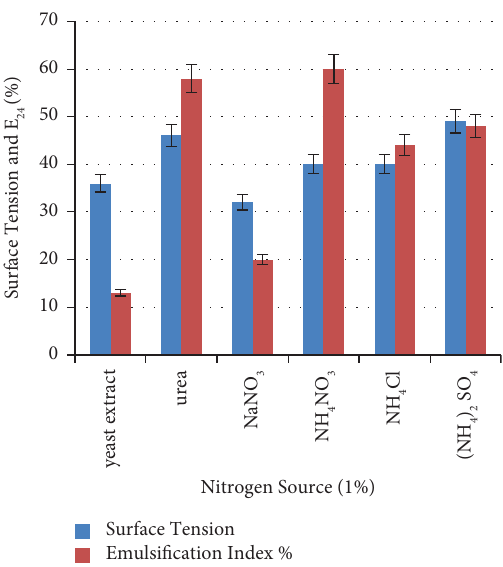
Figure 9: Efect of diferent nitrogen sources on biosurfactant production. NH 4 NO 3 provides optimal results with a 60 ± 0.33% emulsifcation index and 49mN/m surface tension.